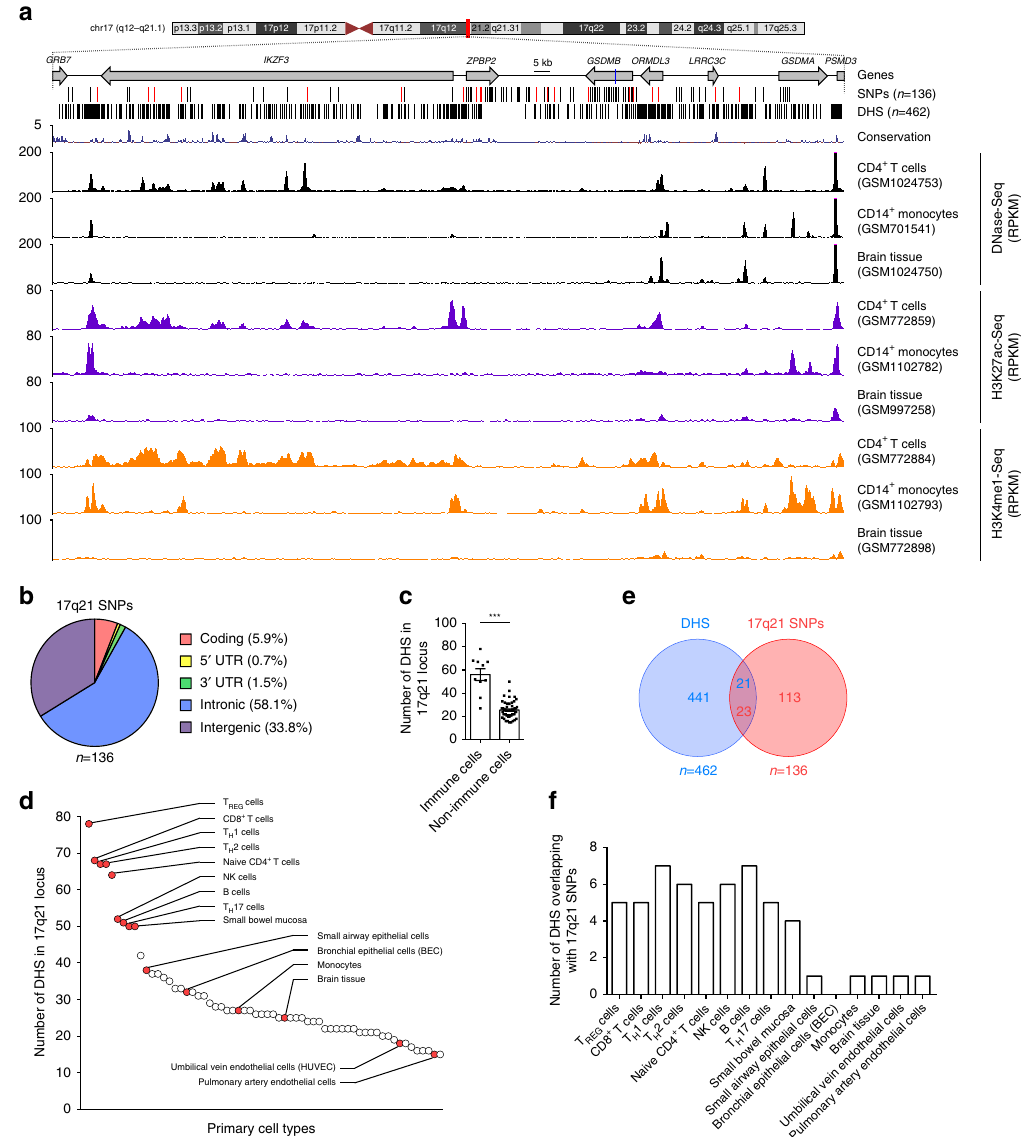
Figure 1 | 17q21 SNPs overlap immune cell enhancers. ( a ) University of California Santa Cruz (UCSC) tracks showing chromosomal location and genes present in the 17q21 locus, containing a large haplotype block of asthma-associated SNPs; the location of asthma-risk SNP rs7216389 is indicated as blue line in the gene track. Black lines indicate SNPs’ genomic location, and red lines are SNPs that overlap peaks of DNase hypersensitivity sites (DHS) from multiple cell types obtained from the ENCODE Encyclopedia (version 2) provided by the ENCODE Project Consortium (see Methods). Exemplary DHS tracks, H3K27ac and H3K4me1 enrichment tracks from CD4 þ Tcells, CD14 þ monocytes and brain tissue (from ENCODE Project and NIH Epigenomics Roadmap Consortiums) are shown along with UCSC multispecies conservation tracks. ( b ) Distribution of asthma-associated 17q21 SNPs in different genomic regions. ( c ) The average number of DHS in the 17q21 locus of immune versus non-immune cell types ( n ¼ 10 and n ¼ 52, respectively) and ( d ) the 62 primary cell types (indicated as dots, profiled by the ENCODE Project Consortium, see Methods) ordered based on the number of DHS in the 17q21 locus. The top hits and discussed cell types are named and marked in red. ( e ) Overlap of DHS and 17q21 SNPs. ( f ) Number of DHS that directly overlap 17q21 SNPs in various cell types (full list in Supplementary Data set 2b). Error bars are mean ± s.e.m.; *** P o 0.001 by Student’s unpaired two-tailed t -test, and following Bonferroni correction for multiple testing. ORMDL3 expression is most affected in primary T cells . In About 17% (23/136) of the SNPs in the 17q21 asthma-risk haploblock directly overlap DHS in the locus (Fig. 1e). Importantly, more than five of the DHS present in immune cells, such as T-cell subsets, B cells and natural killer cells, directly overlap asthma-risk SNPs, whereas DHS present in monocytes, (Supplementary Fig. 2), we assessed expression of two genes in epithelial cells or other irrelevant tissue (brain) overlap one or no the 17q21 locus ( ORMDL3 and GSDMB ) whose expression levels asthma-risk SNPs (Fig. 1f). Thus, our in silico analysis of have been shown to be affected by 17q21 SNPs in previous enhancer profiles suggests that expression of 17q21 genes is most studies 24–26 . Compared with non-immune cells, such as BECs, lung cancer cell lines (A549), and human umbilical vein likely to be perturbed in immune cell types. NATURE COMMUNICATIONS|7:13426|DOI: